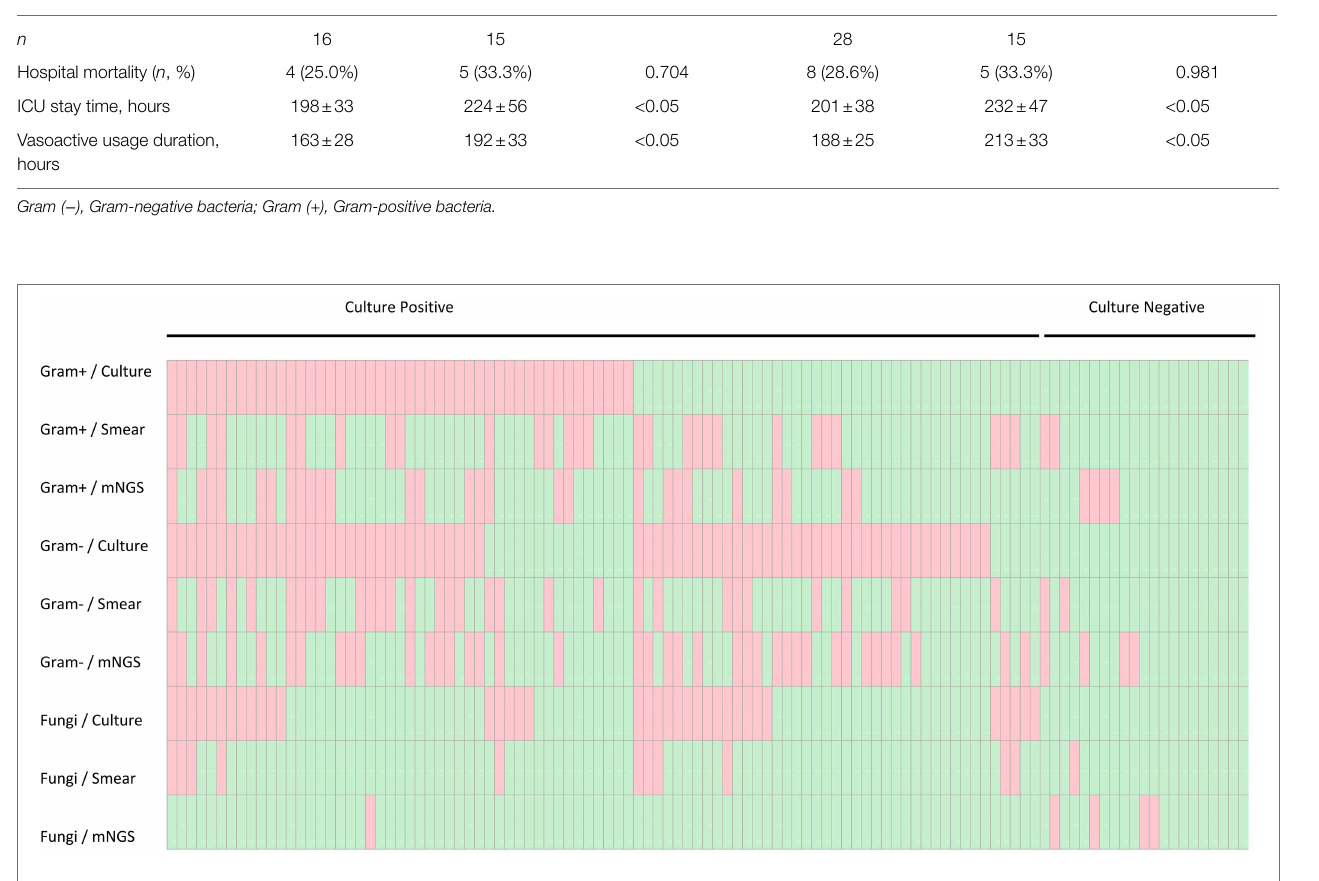
FIGURE 5 | Heatmap depicting plasma mNGS, peritoneal drainage culture and Gram stain smear results stratified by culture result and pathogen category. Gram − , Gram-negative bacteria; Gram+, Gram-positive bacteria.